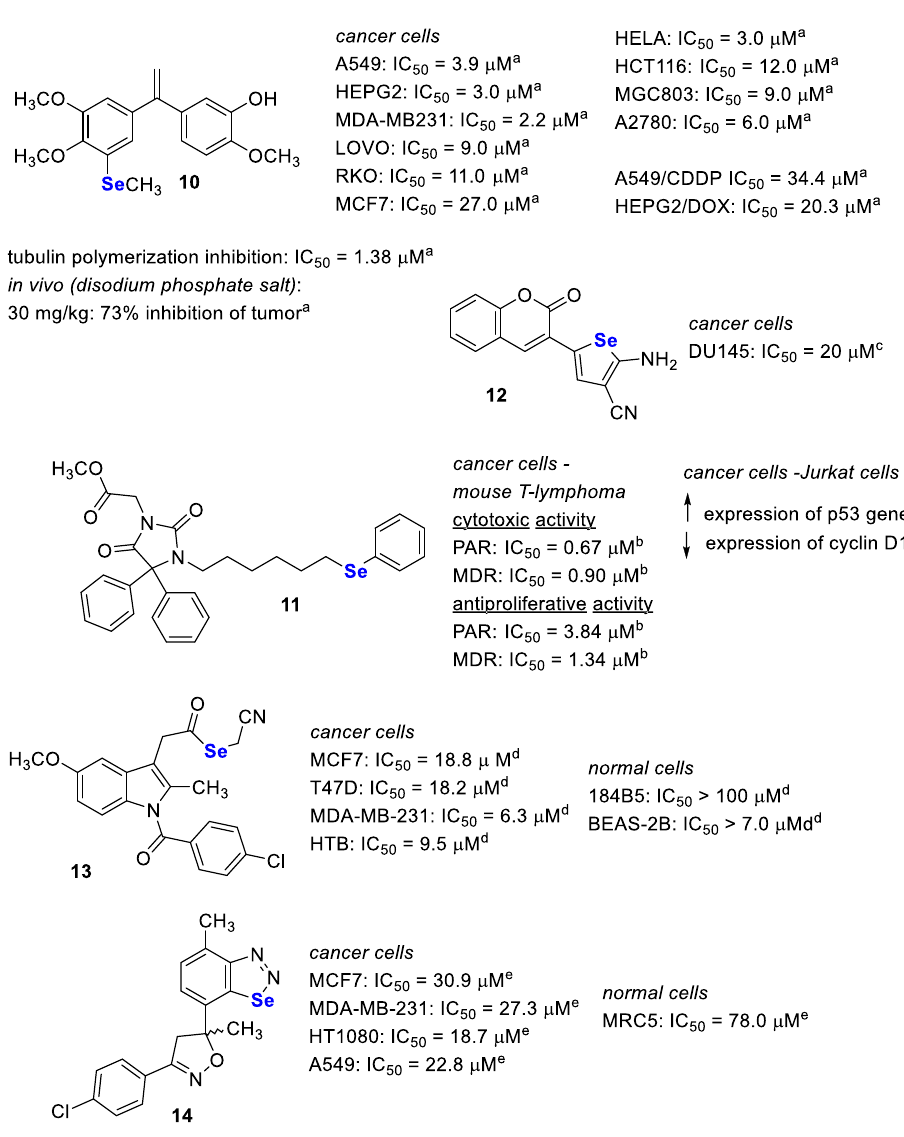
Figure 7. Structures and activity of the most potent selenium-based hybrids 10 - 14 . Data from: a [99], b [102], c [105], d [106], e